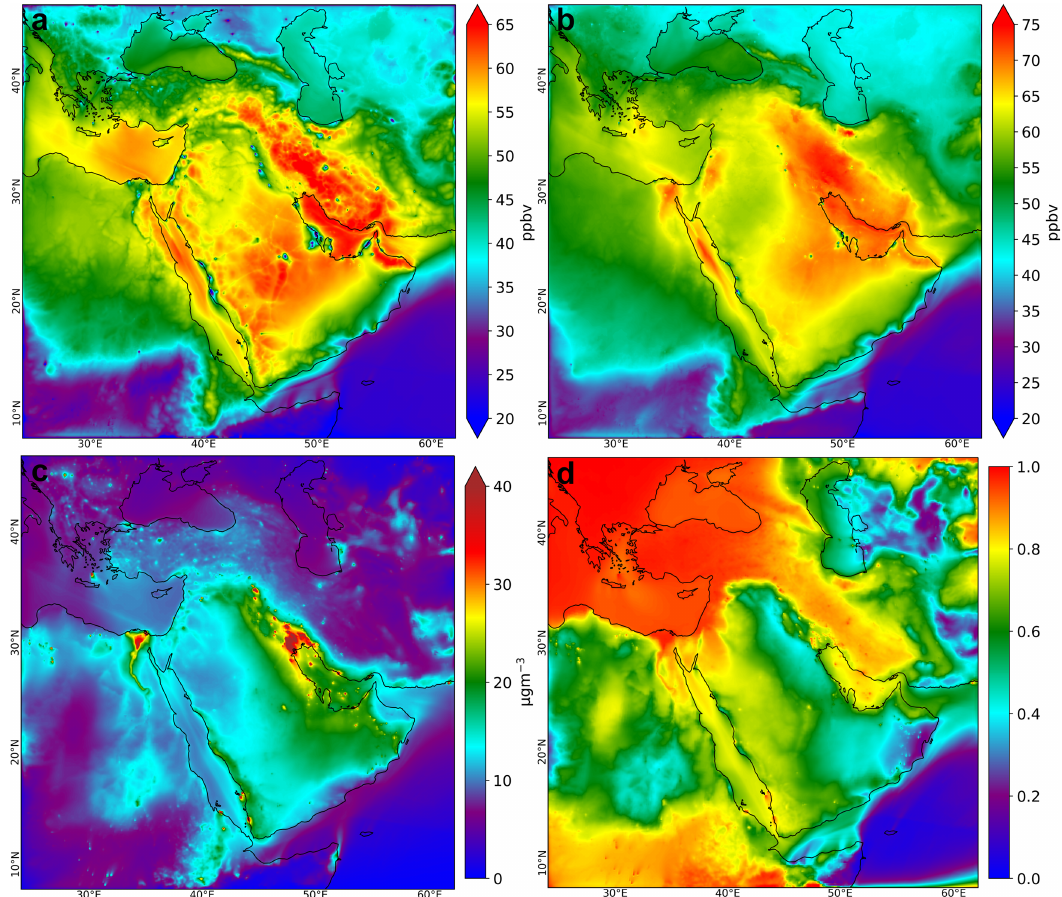
Fig. 2 Model results for ozone and fi ne particulate matter. a Mean O 3 at the surface (ppbv), b daily maximum 8-hourly O 3 (ppbv), c fi ne, submicron PM ( µ g m − 3 ), d anthropogenic fraction of fi ne PM (dominated by ammonium, sulfate, nitrate, black and organic carbon). The biogenic emissions were assumed to be negligible in the region and are not included in the simulation. Figure represents the average of the July – August 2017. Biomass burning is considered